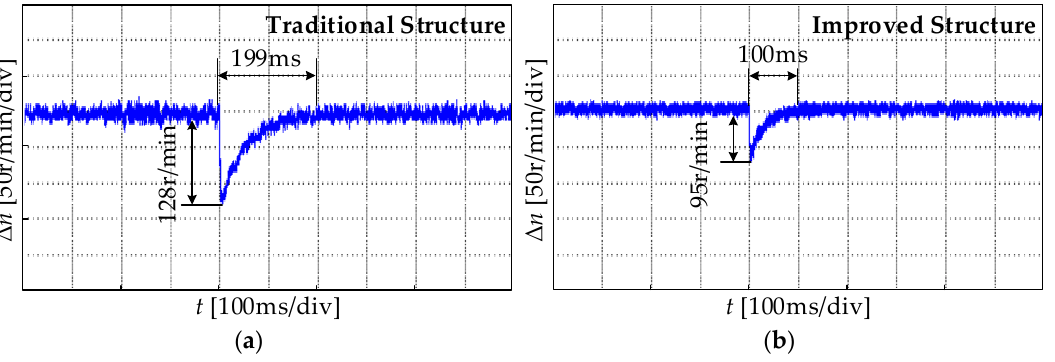
( b ) Figure 16. Electromagnetic torque output of the second motor during the start-up of motors with load: ( a ) Electromagnetic torque output in the traditional structure; ( b ) Electromagnetic torque output in the improved structure. From the above experiments, it should be noted that the starting process of the motor is divided into three stages. In Figures 15a and 16a, the electromagnetic torque outputs of the two motors are saturated within 7 ms in the first stage, and the synchronous compensator does not work at all. In the second stage, the electromagnetic torque output of Motor 1 is still in saturation. As a result of the compensation value, Motor 2 enters the linear region, and its working time is 173 ms. In the third